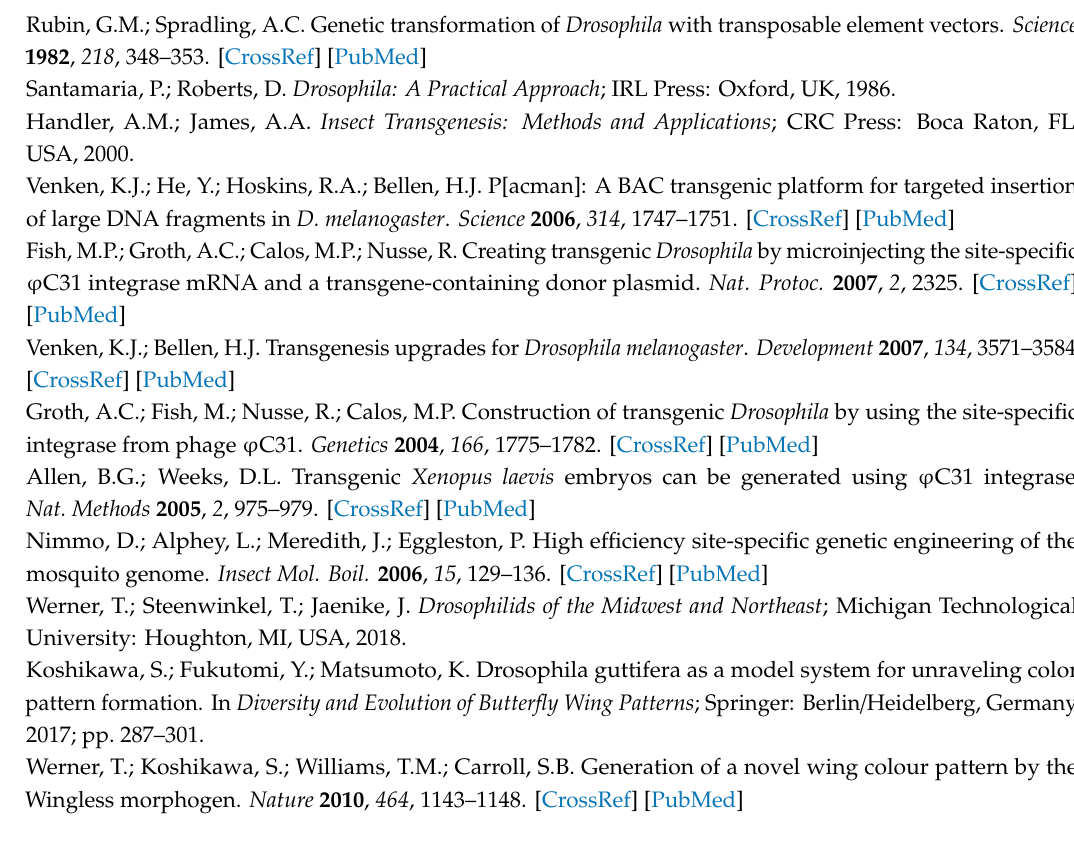
Figure S1: The Narishige IM 300 Microinjector, Video S1: The Making of Transgenic Drosophila guttifera